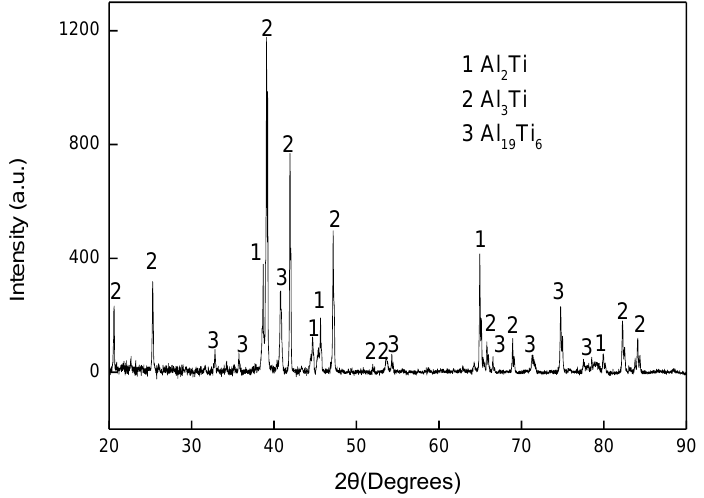
Figure 9. XRD pattern for cross-sectioned Ti-6Al-4V aluminised at 1000 °C for 1 h.